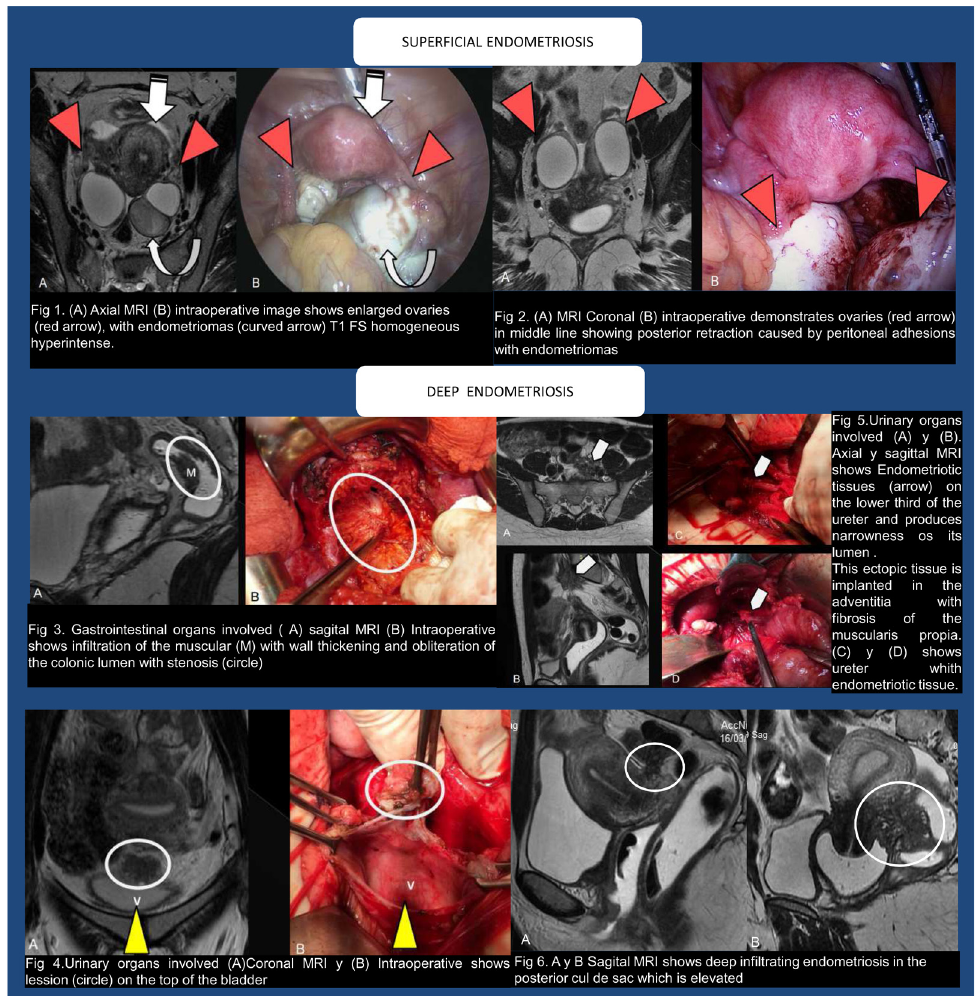
Figure 1. High-resolution magnetic resonance imaging and laparoscopic